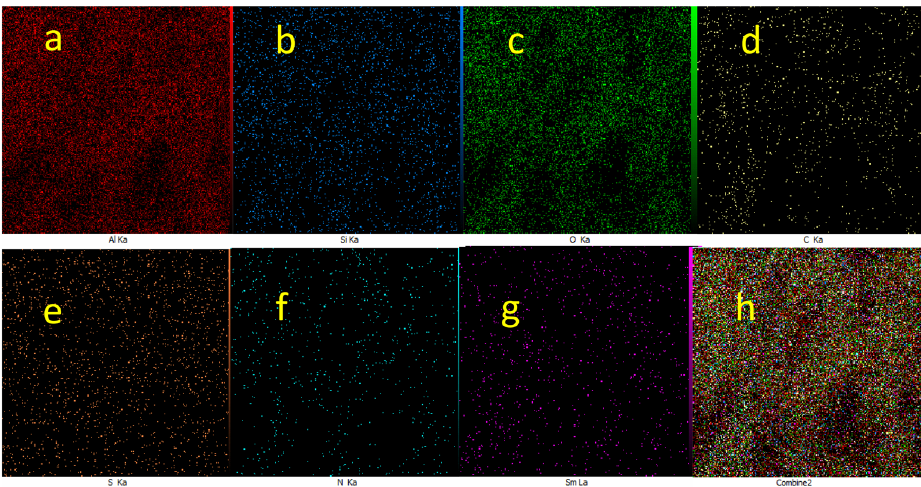
Figure 5. Elemental mapping of ( a ) Al, ( b ) Si, ( c ) O, ( d ) C, ( e ) S, ( f ) N, ( g ) Sm and ( h ) combine of all elements for